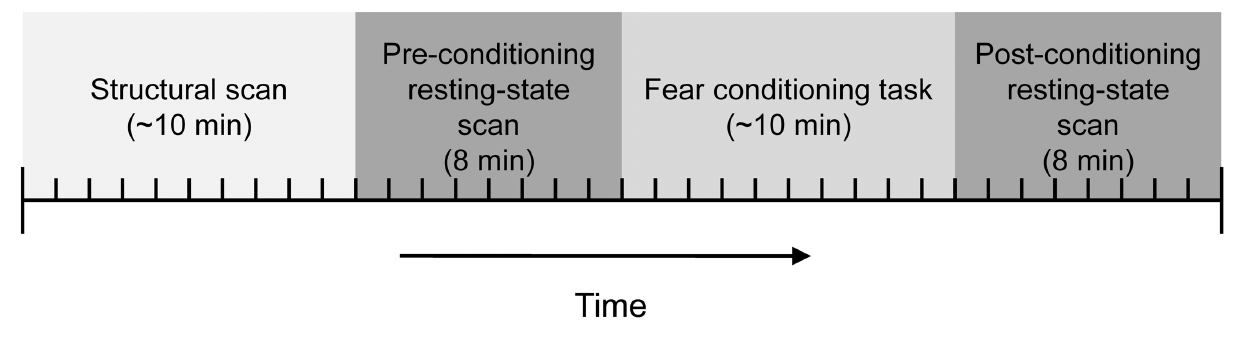
FIGURE 1 | Diagram of the phases in the